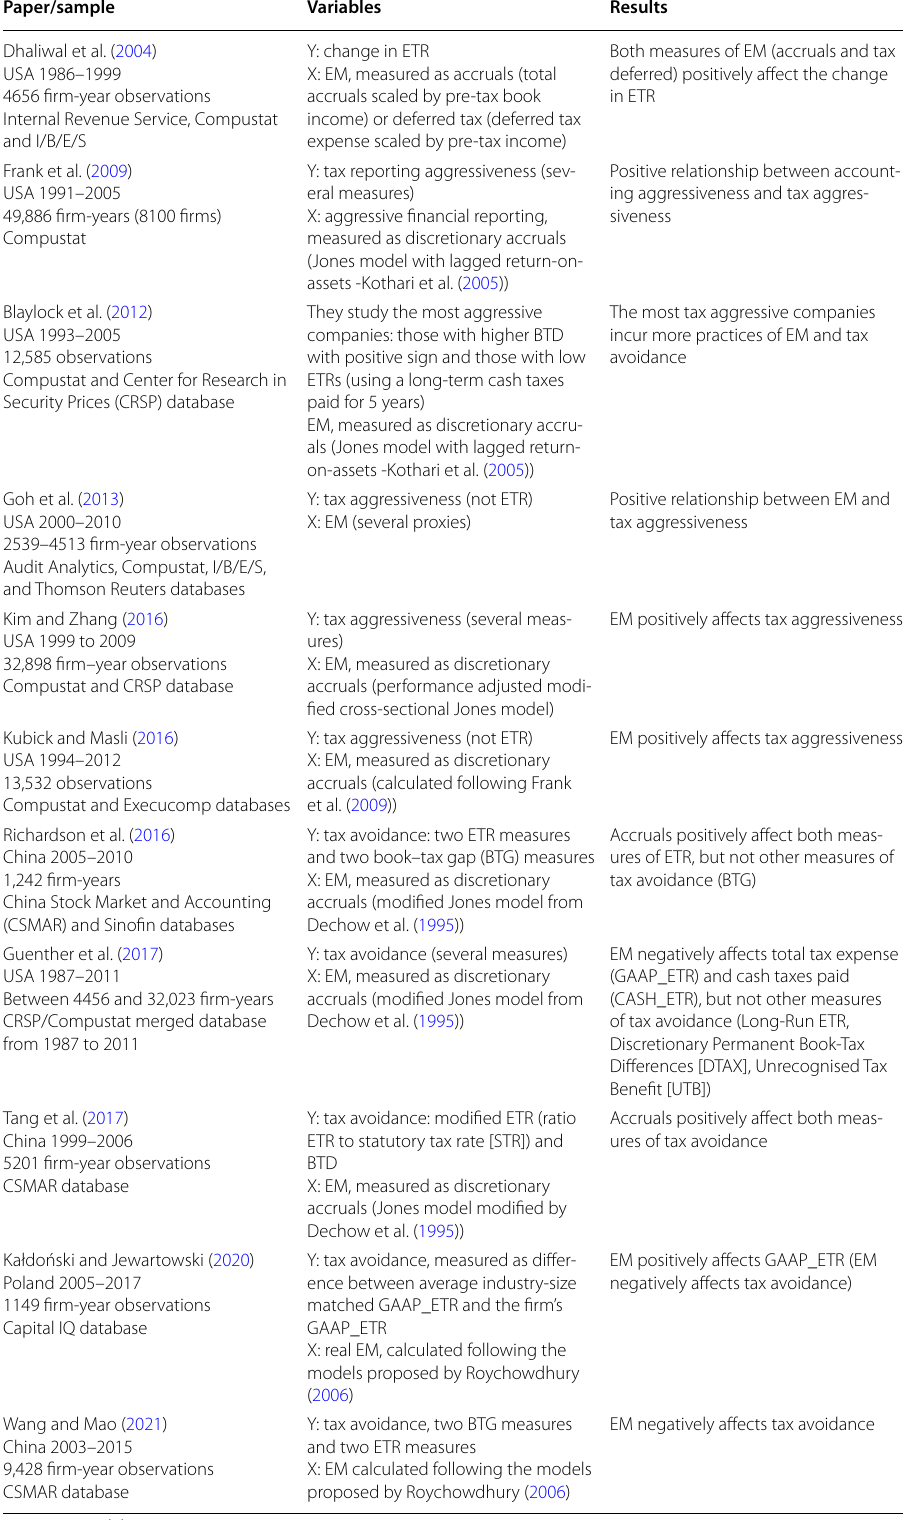
Table 1 Summary of selected studies on tax avoidance and earnings